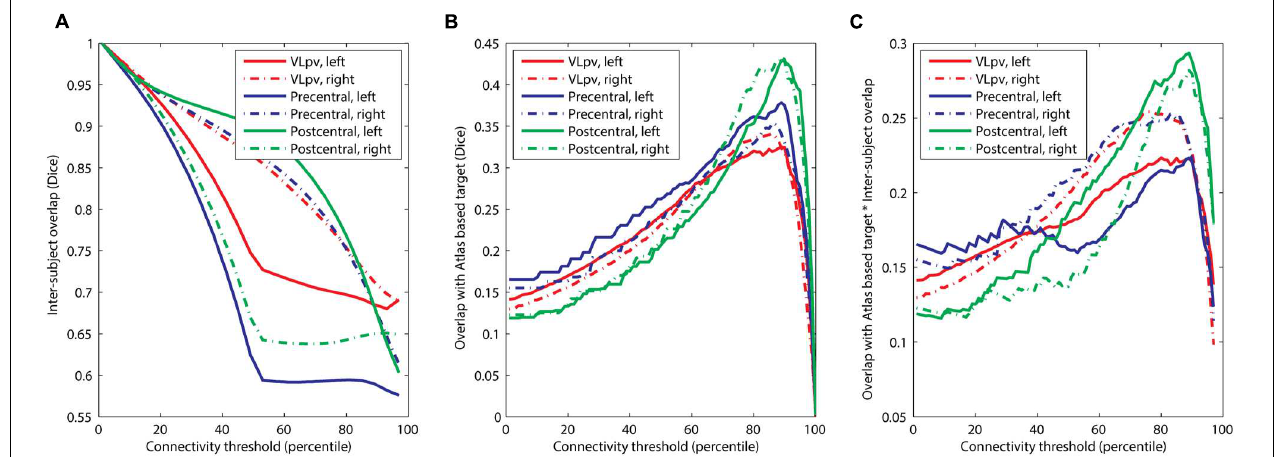
FIGURE 4 | Optimization of the connectivity threshold applied to connectivity based intrathalamic targets. (A) Inter-subject overlap as a function of the applied connectivity threshold ; (B) overlap with anatomical atlas as a function of the applied connectivity threshold ; (C) determining the population-level optimal threshold value as a maximum point of the